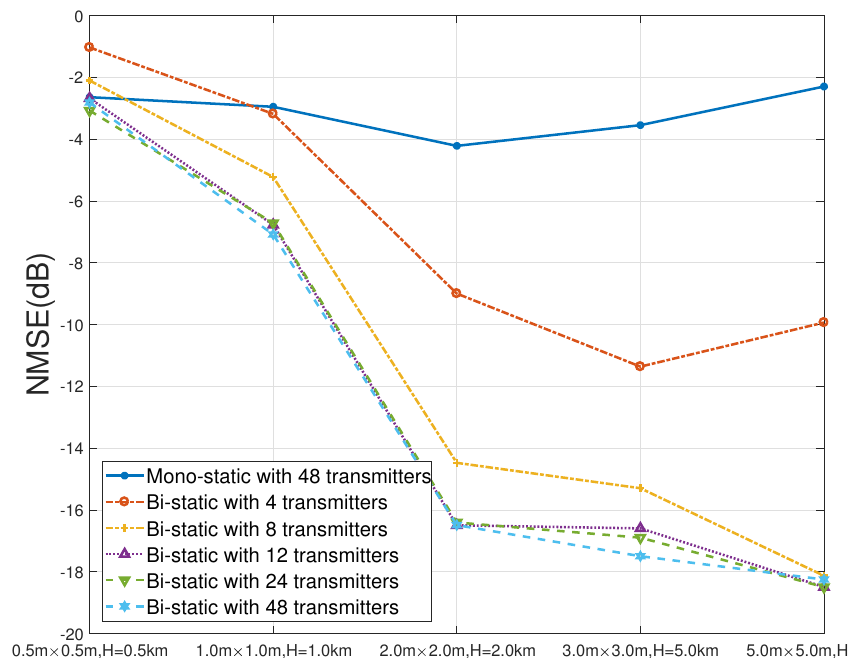
Figure 11. NMSEs of the imaging results by mono-static and bi-static MSCI at different imaging distances and different grid